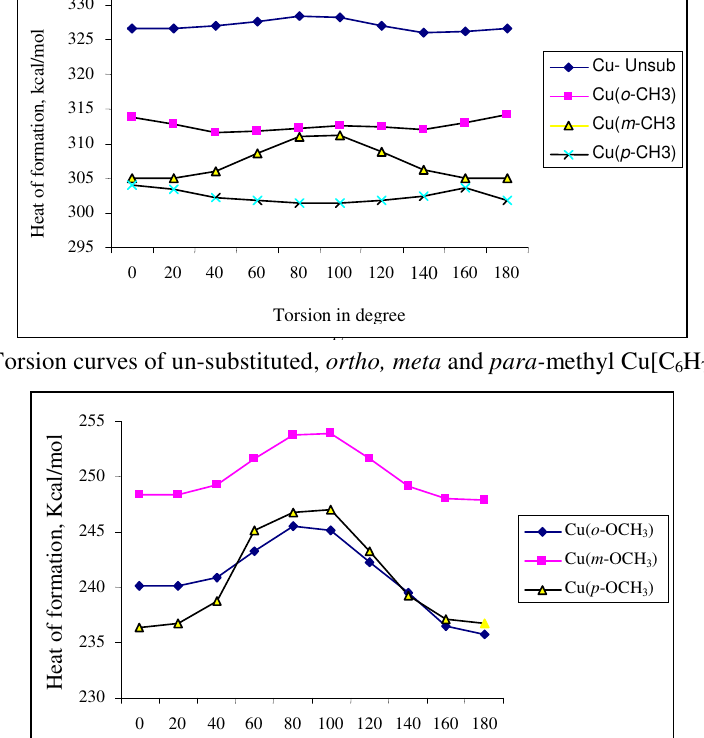
Figure 6. Torsion curves of un-substituted, ortho, meta and para- methyl Cu[C